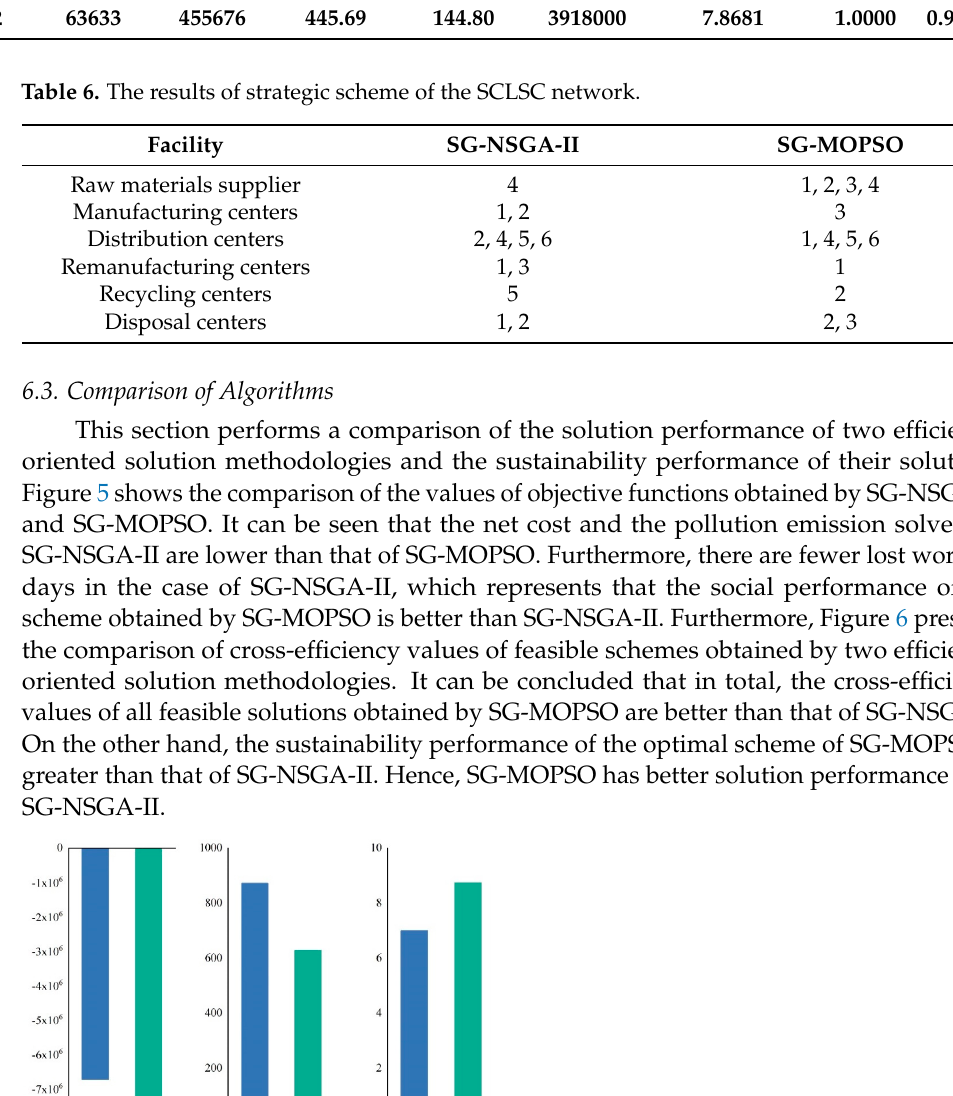
Table 6. The results of strategic scheme of the SCLSC network.